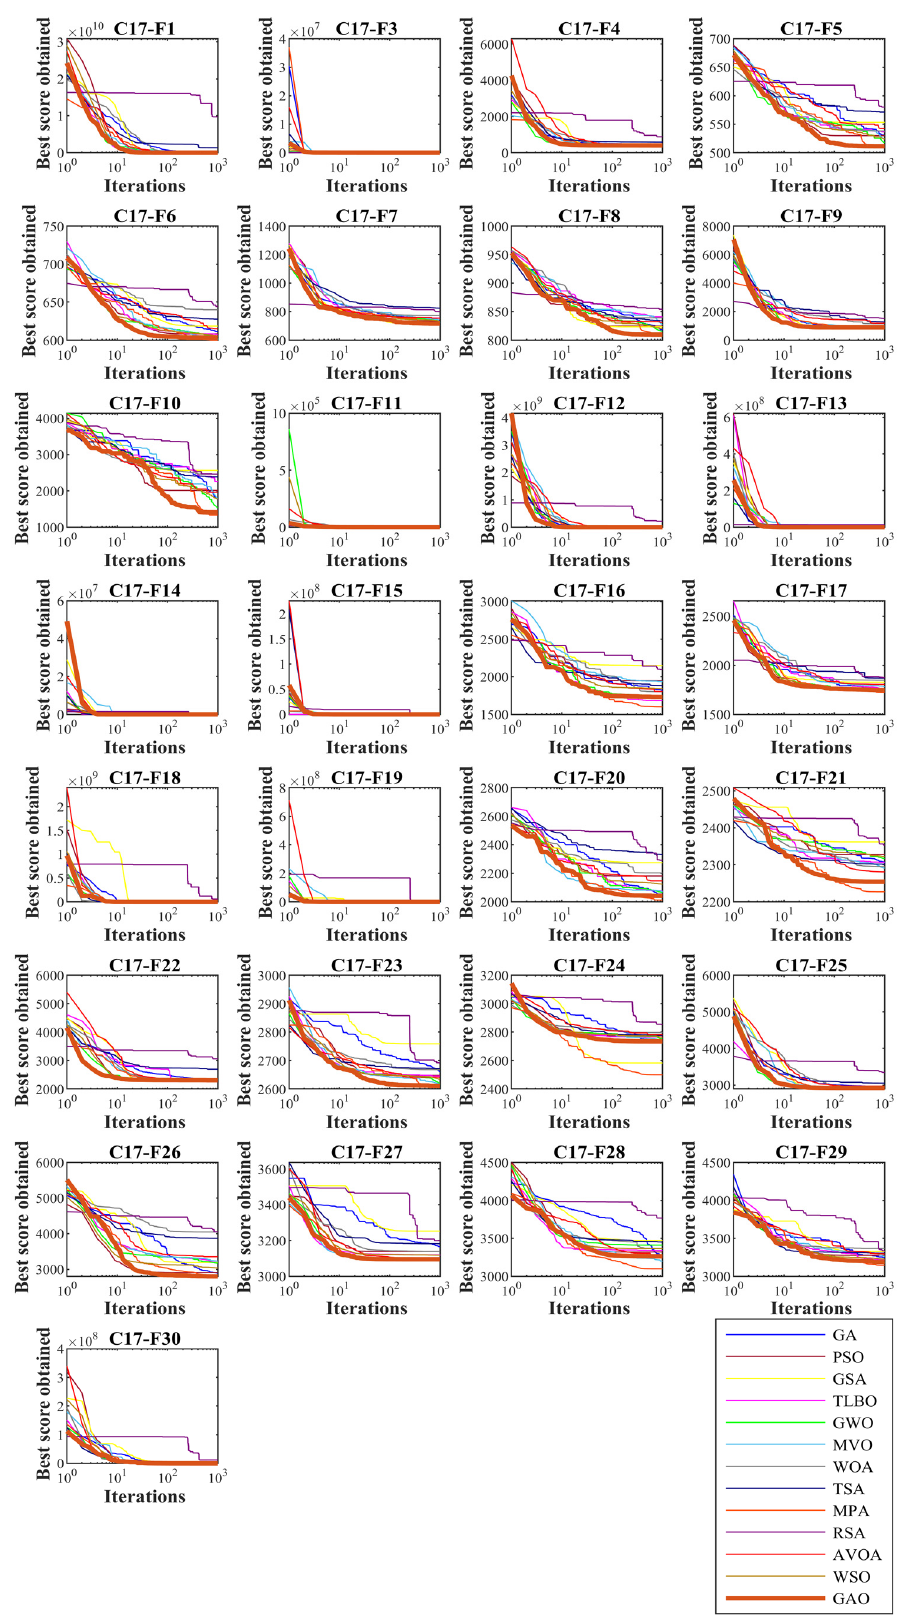
Figure 3. Convergence curves of GAO and competitor algorithms performance on the CEC 2017 test suite (dimension 𝑚 = 10 ).